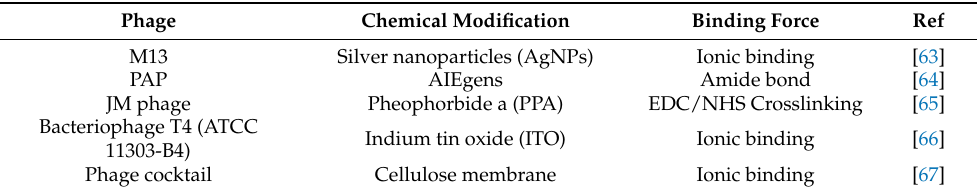
Table 2. Chemical engineering methods applied for phage modification. EDC/NHS: